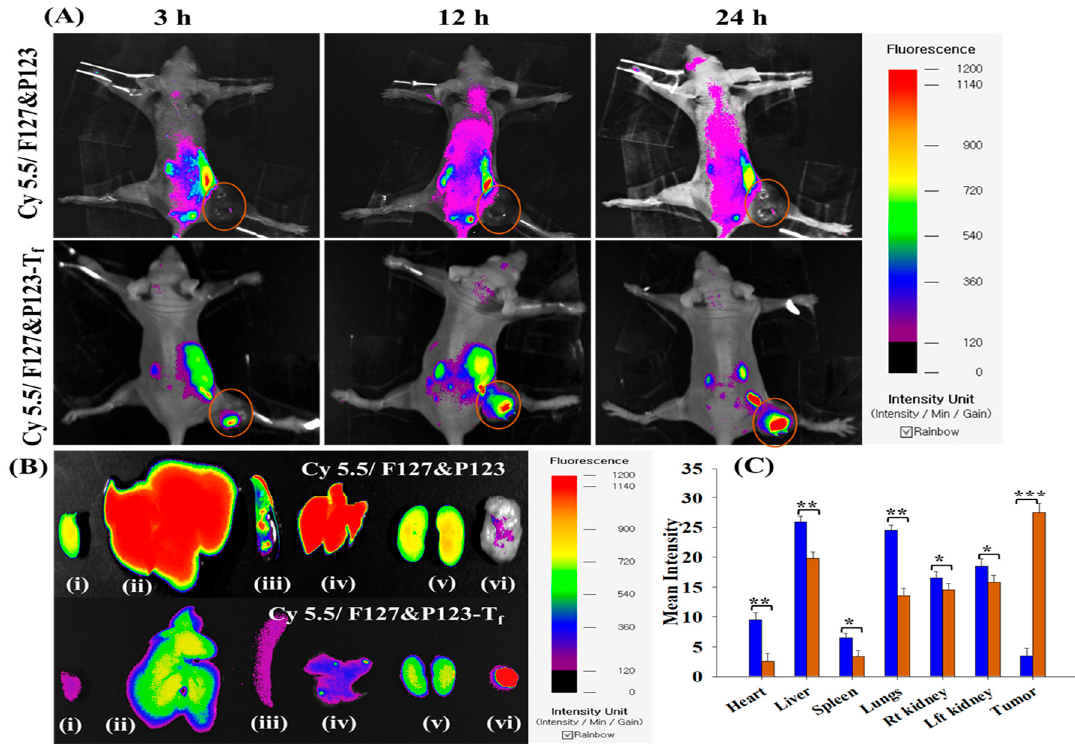
Figure 6. ( A ) In vivo biodistribution pattern of Cy5.5/F127&P123 and Cy5.5/F127&P123-T f in MDA-MB-231(R) tumor-bearing mice; ( B ) ex vivo tissue distribution of Cy5.5/F127&P123 and Cy5.5/F127&P123-T f in (i) heart, (ii) liver, (iii) spleen, (iv) lungs, (v) kidneys, and (vi) tumor excised from MDA-MB-231(R) tumor-bearing mice; ( C ) quantification of fluorescent signals from part B; data shown represent mean ± SD ( n = 3).